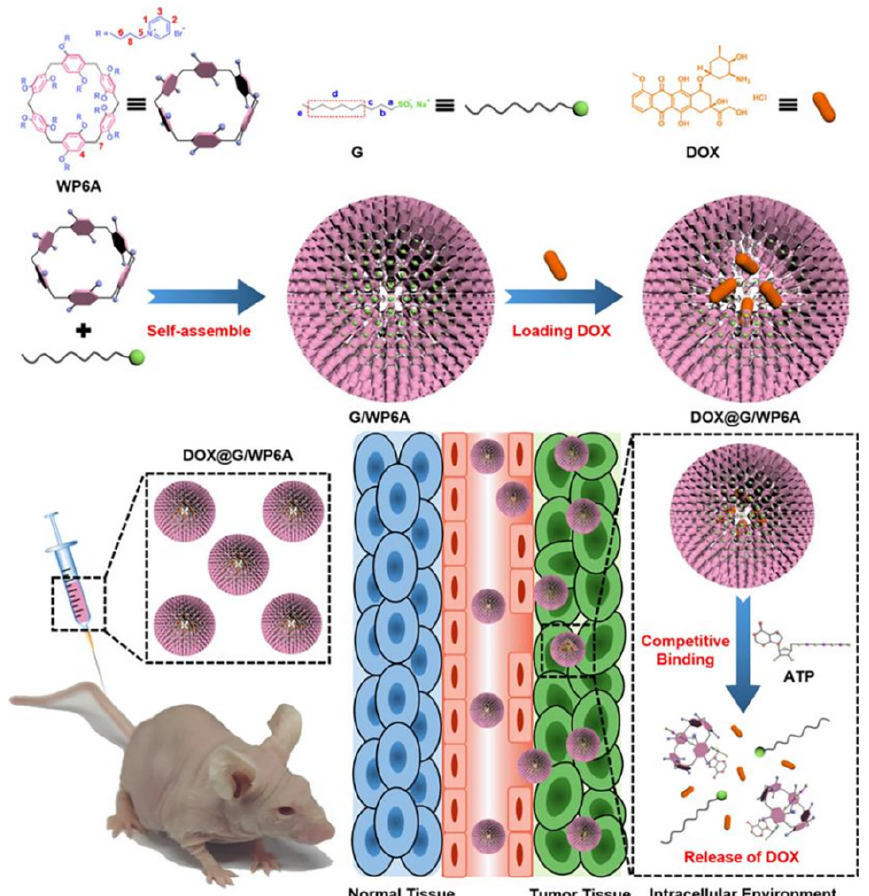
Figure 9. The preparation of supramolecular self − assembled complexes, DDS (DOX@G/WP6A) (reproduced with permission of American Chemical Society from ref. [72]).